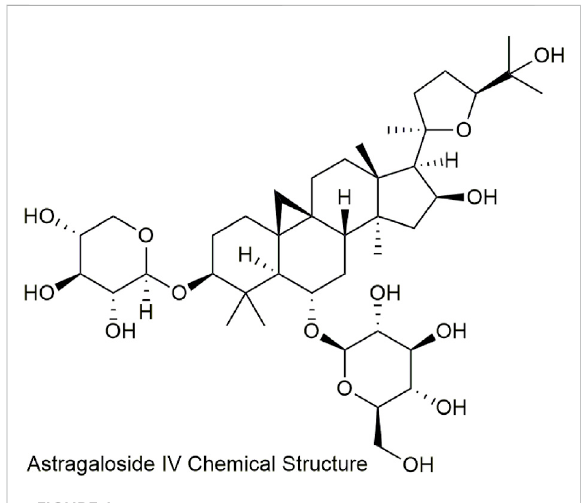
FIGURE 1 The chemical structure of Astragaloside